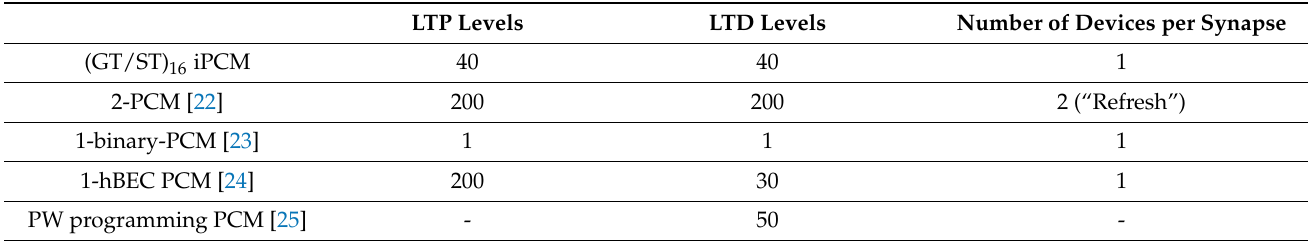
Table 2. Comparison of synaptic characteristics of the (GeTe/Sb 2 Te 3 ) 16 iPCM with different types of